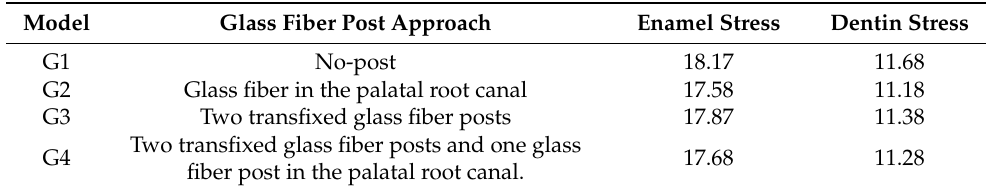
Table 3. Von-Mises stress peaks (MPa) obtained in enamel and dentin tissue after the analysis process.